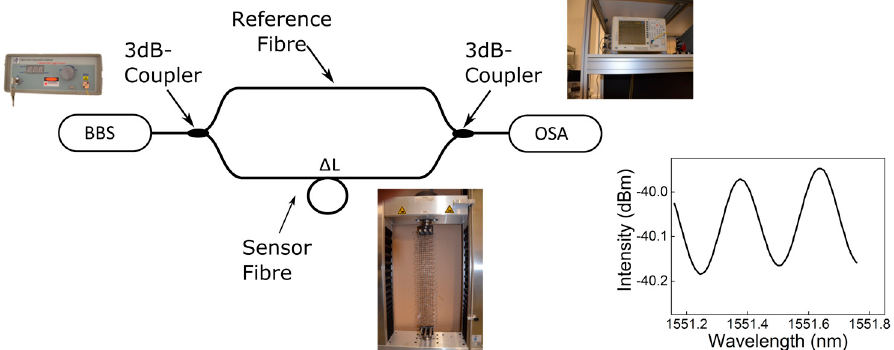
Figure 5. Developed fiber optical MZI to evaluate and characterize the force transfer between the carbon structure and the optical fiber of the